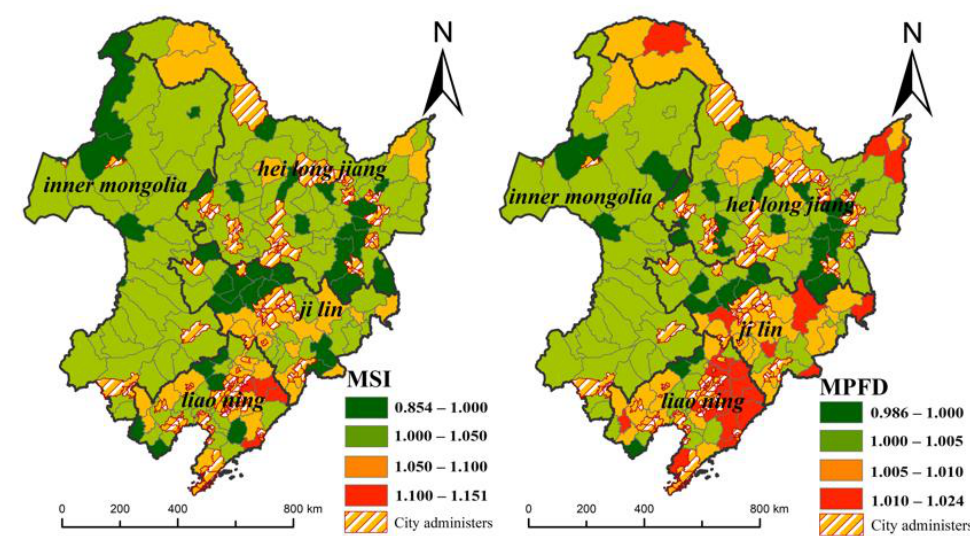
Figure 4. Landscape shape characteristics of rural settlements in Northeast China.